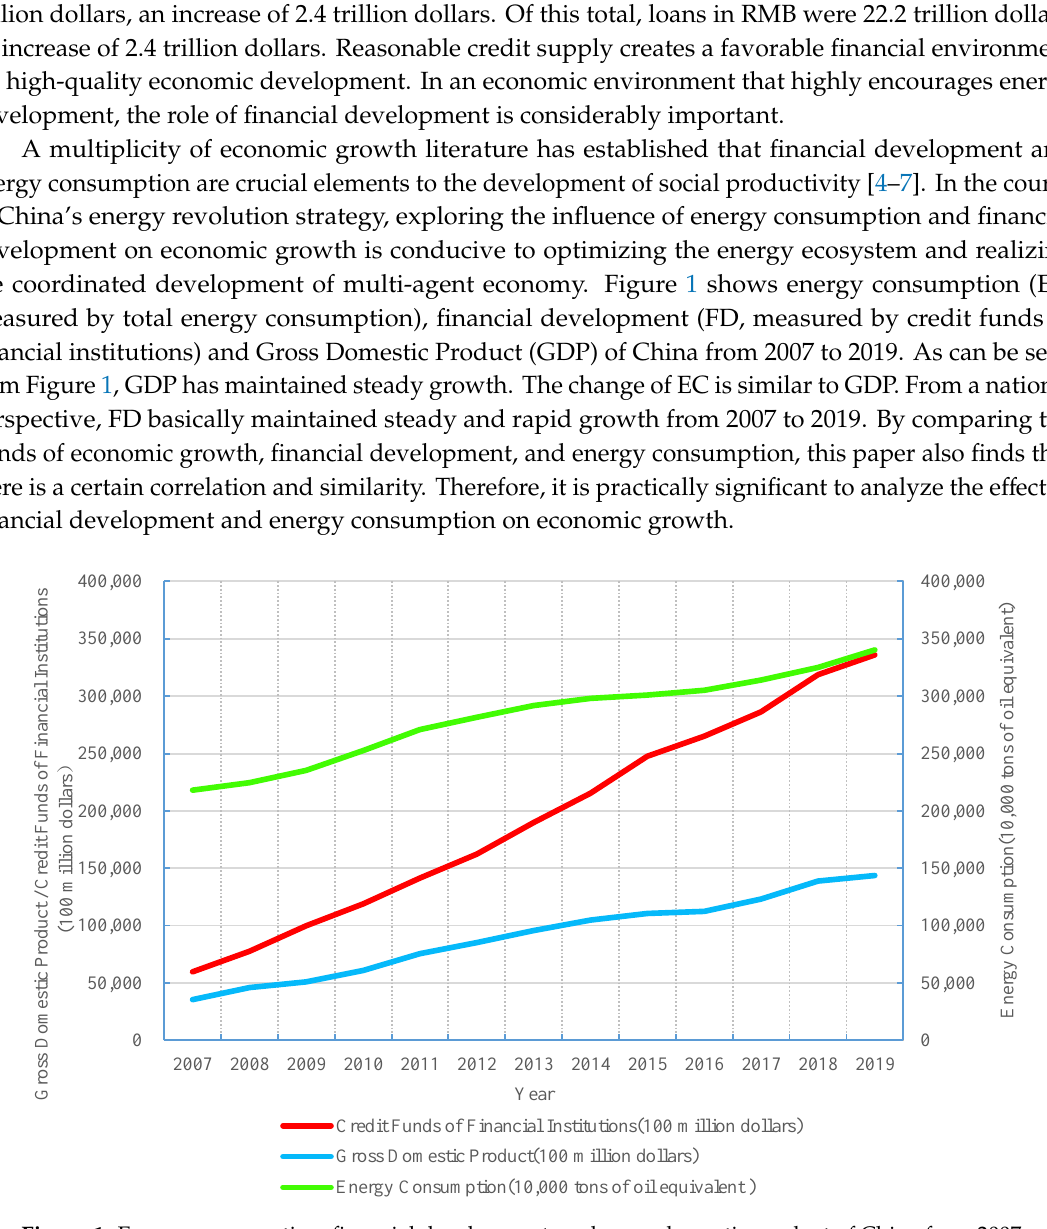
Figure 1. Energy consumption, financial development, and gross domestic product of China from 2007 to 2019. Data Sources: China Statistical Yearbook [ 8 ].